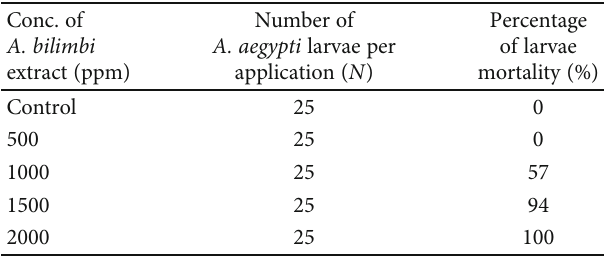
Table 1: Mortality of third-instar Ae. aegypti larvae from Surabaya after being exposed to various concentrations of Averrhoa bilimbi extract for 24